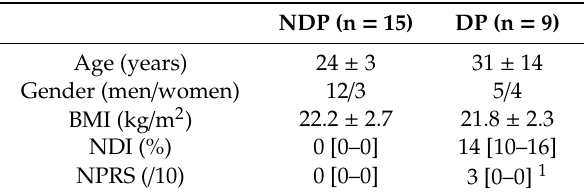
Table 1. Characteristics of the participants in NDP and DP groups. Data are given either under mean ± SD or median [Q1–Q3] form.